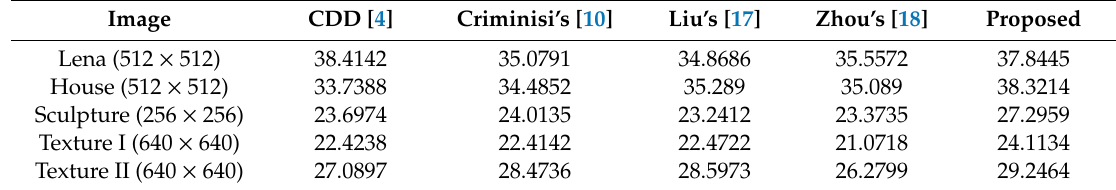
Table 1. Peak signal to noise ratio (PSNR) (dB) comparison of Figure 7, Figure 8, Figure 9, Figure 10 and Figure 11.